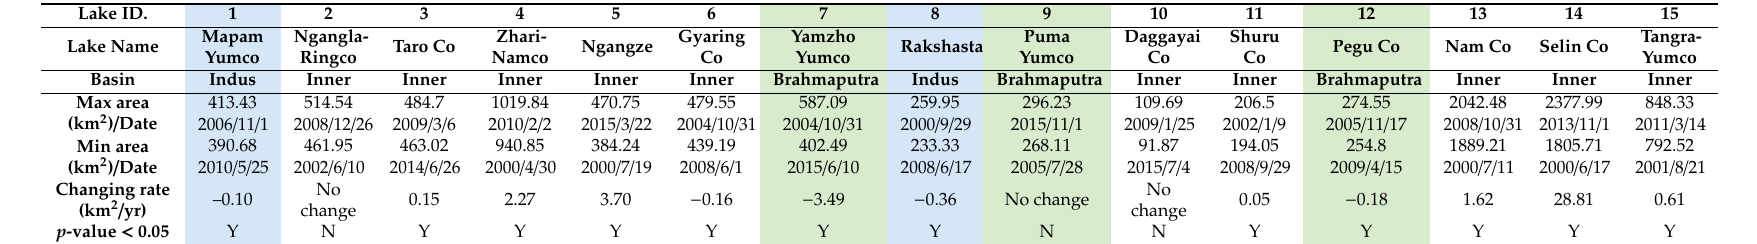
Table 3. Inundation changes of the studied lakes 3